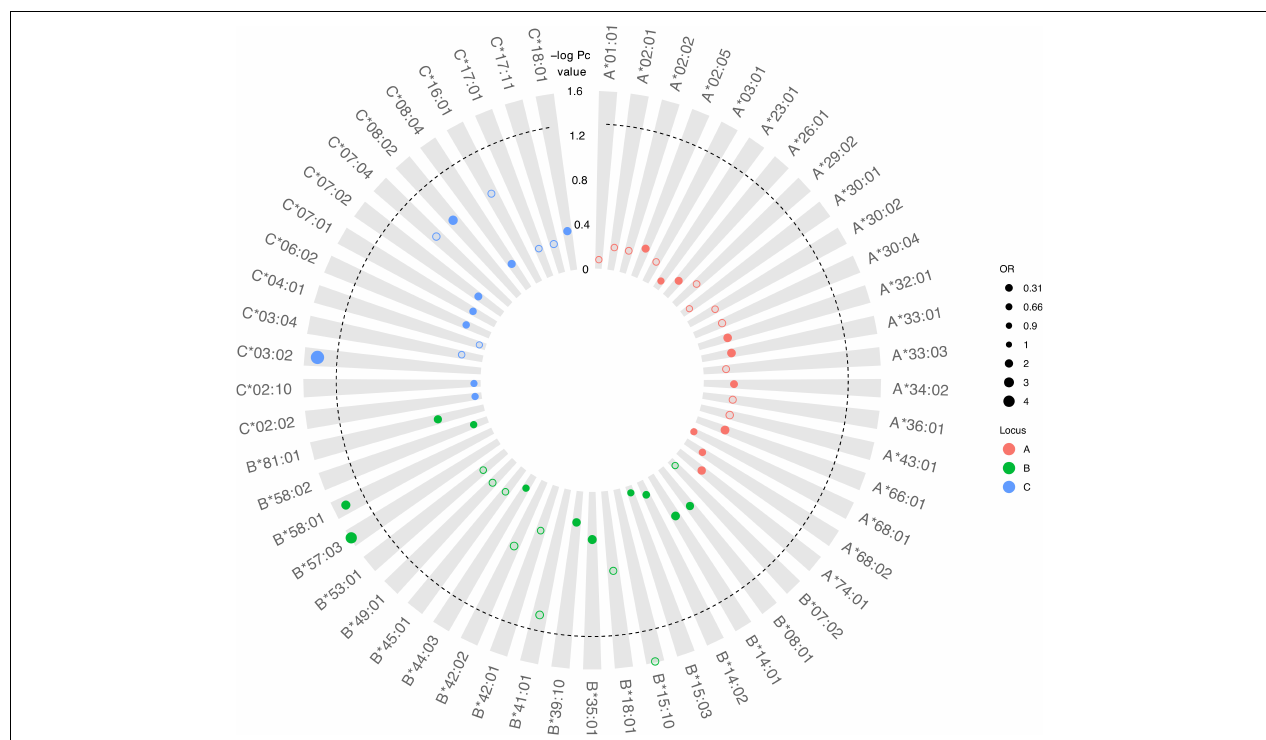
FIGURE 4 | Circular bubble plot of the Class I HLA association with LTNP in the CafGEN cohort. Each bubble represents an HLA class I allele and the distance from the center is a measure of the negative log of the correct P ( Pc ) value. Protective alleles are represented with solid bubbles while the susceptible alleles are shown in blank bubbles. The size of the bubbles depicts the odds ratio from unity. The broken line represents the cut off of Pc value ( < 0.05).